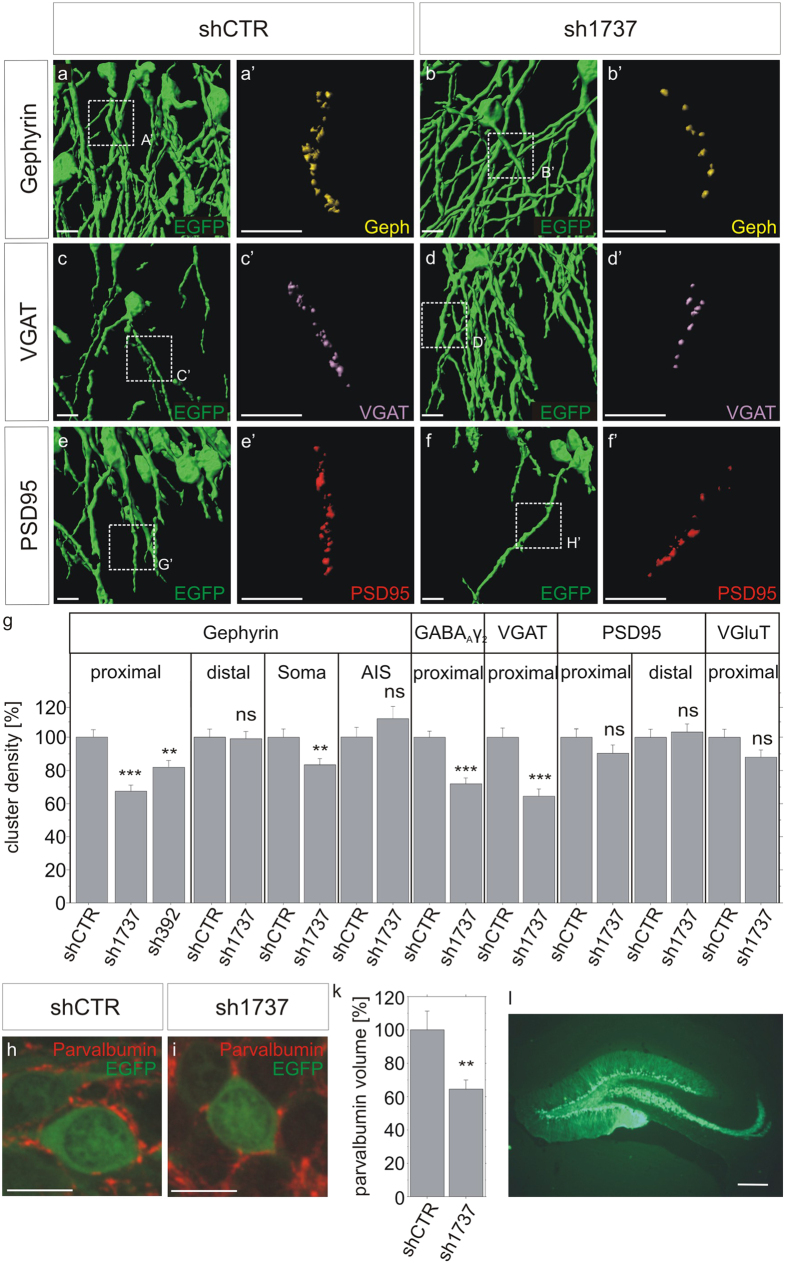
EphA7 is required for the stabilisation of GABAergic synaptic markers at proximal dendrites and somata of granule cells in vivo.(a–g) Lentiviral vectors were stereotaxically injected into the dentate gyrus of adult female rats. For the identification of transduced principal neurons, lentiviral constructs expressed EGFP under the control of the CamKII promoter. Likewise, EphA7-specific shRNA 1737 or sh392 were coexpressed from the same vector as indicated. Brain slices were stained for pre- and postsynaptic, inhibitory and excitatory synapse markers VGAT, gephyrin, VGluT, PSD95, and the γ2 subunit of GABAA receptors, respectively. Example micrographs are shown in a-f. Insets in (a–f) are enlarged in (a’–f’). All images were rendered using IMARIS software. Scale bars, 10 μm. (g) Quantification of synaptic marker densities on different compartments of granule cells as indicated. Proximal dendritic segments: gephyrin, n = 140, ***p < 0.0001; GABAA γ2, n = 40, ***p < 0.0001; VGAT, PSD95, VGluT, n = 90, ***p < 0.0001; ns, not significant. Distal dendritic segments: gephyrin, PSD95, n = 70; ns, not significant. Soma: gephyrin, n = 60, **p < 0.01. Axon initial segment (AIS): gephyrin, n = 60; ns, not significant. ANOVA, Fisher-PLSD; error bars: S.E.M. (h,i) Representative images of granule cells transduced with control or EphA7 knockdown lentivirus coexpressing EGFP and stained for parvalbumin. (k) Parvalbumin-stained voxels representative for basket cell terminals were identified and quantified as objects in confocal z-stacks. The volume of parvalbumin-positive structures per contacted soma were determined as a measure for basket cell innervation after EphA7 knockdown (65%) compared to control (100%). n = 26, **p < 0.01; ANOVA, Fisher-PLSD; error bars: S.E.M. scale bars: 10 μm. (l) Representative image of EGFP fluorescence indicating lentiviral infection of the dentate gyrus. Scale bar 200 μm.